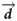
Histograms of the relative frequency (%) of the magnitude of change d→ per world region.(A) Relative frequency as a function of the observed direction of change. (B) Relative frequency as a function of LISA cluster: HH, High-high; LL, Low-low; LH, Low-high; HL, High-low [14]. Cumulative relative frequencies less than 100% indicate values with d→>1 which have been omitted in the figure for clarity.